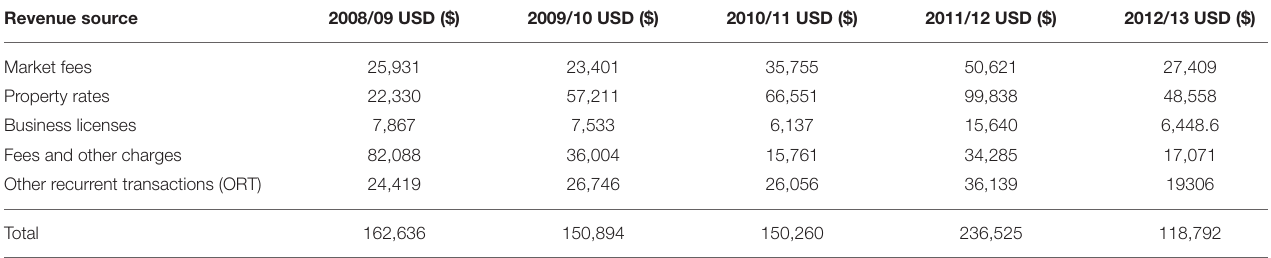
TABLE 4 | Sources of revenue for Luchenza City Council